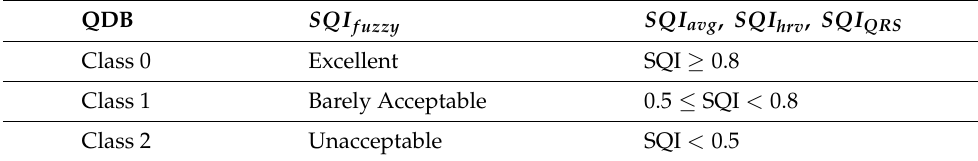
Table 4. Aligning pipeline outputs with QDB labels for evaluation.